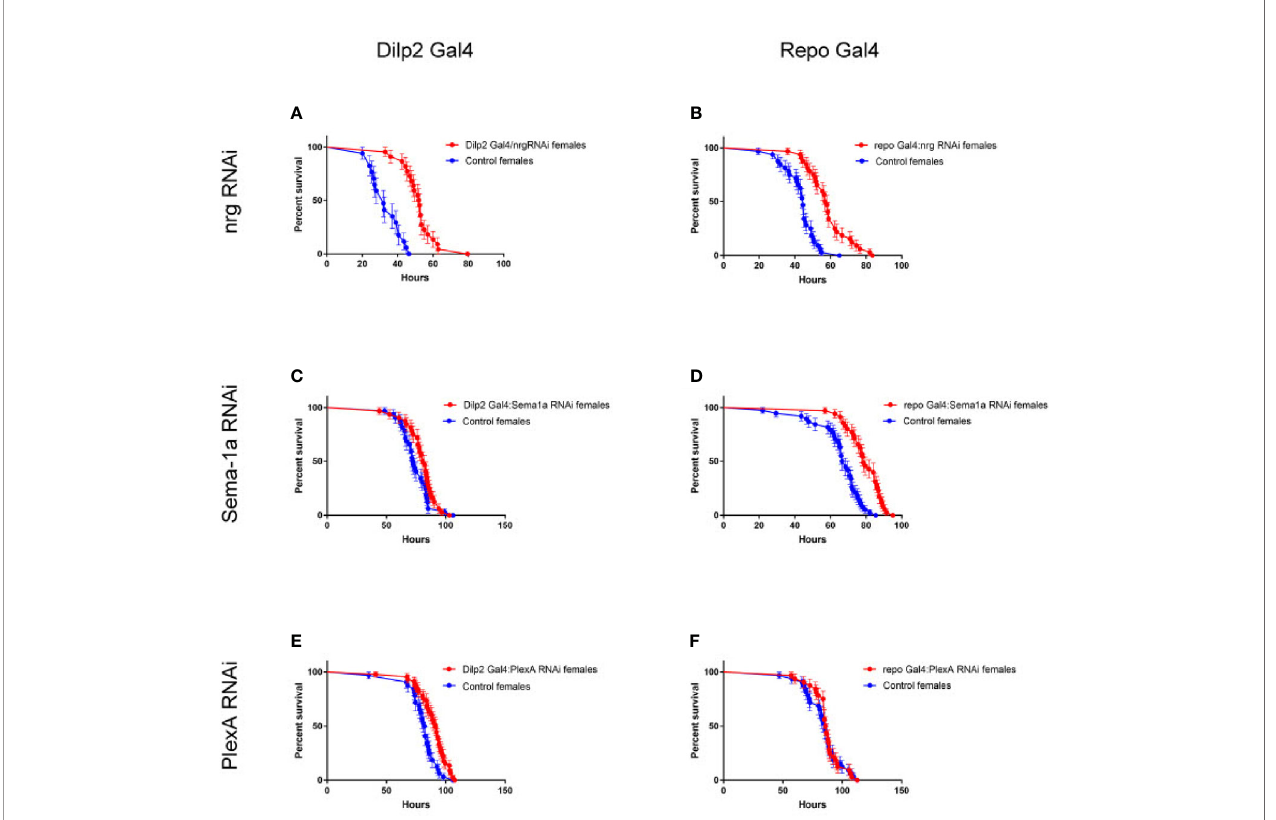
FIGURE 9 | Cell-type speci fi c loss of nrg, Sema-1a , and PlexA gives rise to starvation stress survival phenotypes. (A) Knockdown of nrg in IPCs with Dilp2 Gal4 results in increased starvation resistance (IPCs: P<0.0001, log-rank test; control median survival = 32 hours, RNAi median survival = 52.25 hours; (B) and in Glia: P<0.0001, log-rank test; control median survival = 44.5 hours, RNAi median survival = 57.5 hours). Knockdown of Sema-1a in IPCs (C) does not signi fi cantly affect survival (P=0.1120, log-rank test; control median survival = 72.25 hours, RNAi median survival = 81.25 hours), while knockdown of Sema-1a in glia (D) extends survival by 16% (P<0.0001, log-rank test; control median survival = 67.5 hours, RNAi median survival = 78.5 hours). The opposite is seen with PlexA , where knockdown of PlexA in IPCs (E) does extend survival by 11% (P=0.0014, log-rank test; control median survival = 82.25 hours, RNAi median survival = 91.5 hours), while knockdown of PlexA in glia (F) does not affect survival (P=0.7509, log-rank test; control median survival = 85.5 hours, RNAi median survival = 86.25